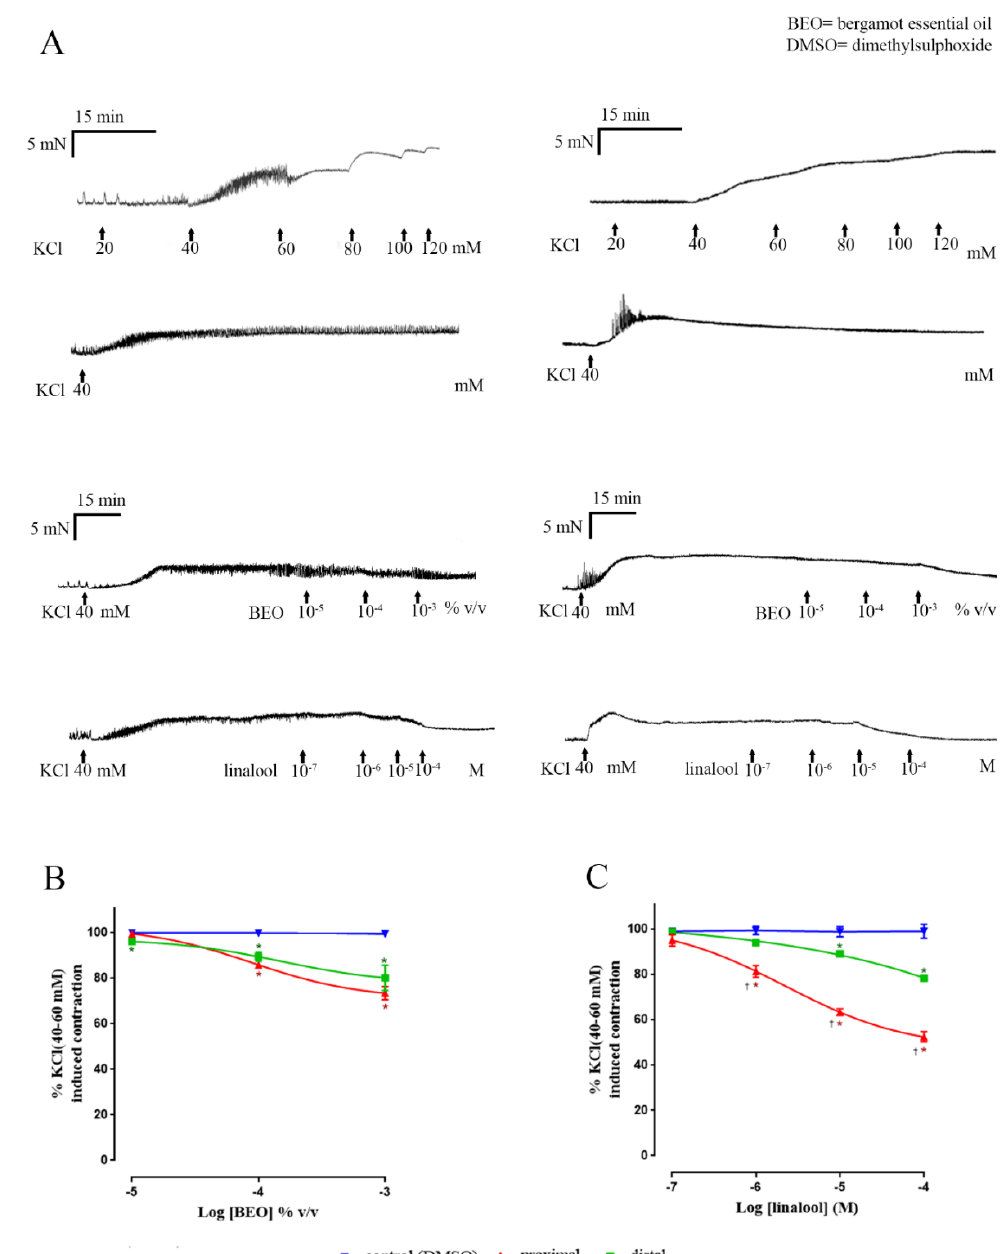
Figure 5. Inhibition by BEO and linalool of the contraction evoked by a submaximally-e ff ective concentration of KCl in rat isolated colon. Panel ( A ) shows examples of experimental records (records on left and right show the e ff ect observed in proximal and distal colon, respectively) illustrating a cumulative concentration-response curve to KCl and the e ff ects of vehicle, BEO and linalool on the sustained contraction evoked by the submaximally-e ff ective concentration of KCl. Panel ( B ) shows the concentration–response curve for BEO and panel ( C ) shows the concentration–response curve for linalool in both regions of colon. Note that the values for BEO are given as volume / volume of bathing solution, whereas the concentrations of linalool are given as molar values. Each point represents the mean of animals studied: BEO n = 4 ( n = 4 proximal and n = 4 distal) and linalool n = 4 ( n = 4 proximal and n = 4 distal). The cumulative concentration e ff ect was fitted by non-linear regression to a three or four-parameter Hill equation. Vertical lines show mean ± sem. * p ≤ 0.05 shows the statistical significance between proximal (symbols in red, *) or distal (symbols in green, *) colon versus control ( t- tests). † p < 0.05 shows the statistical significance between the inhibition produced in proximal and distal colon ( t